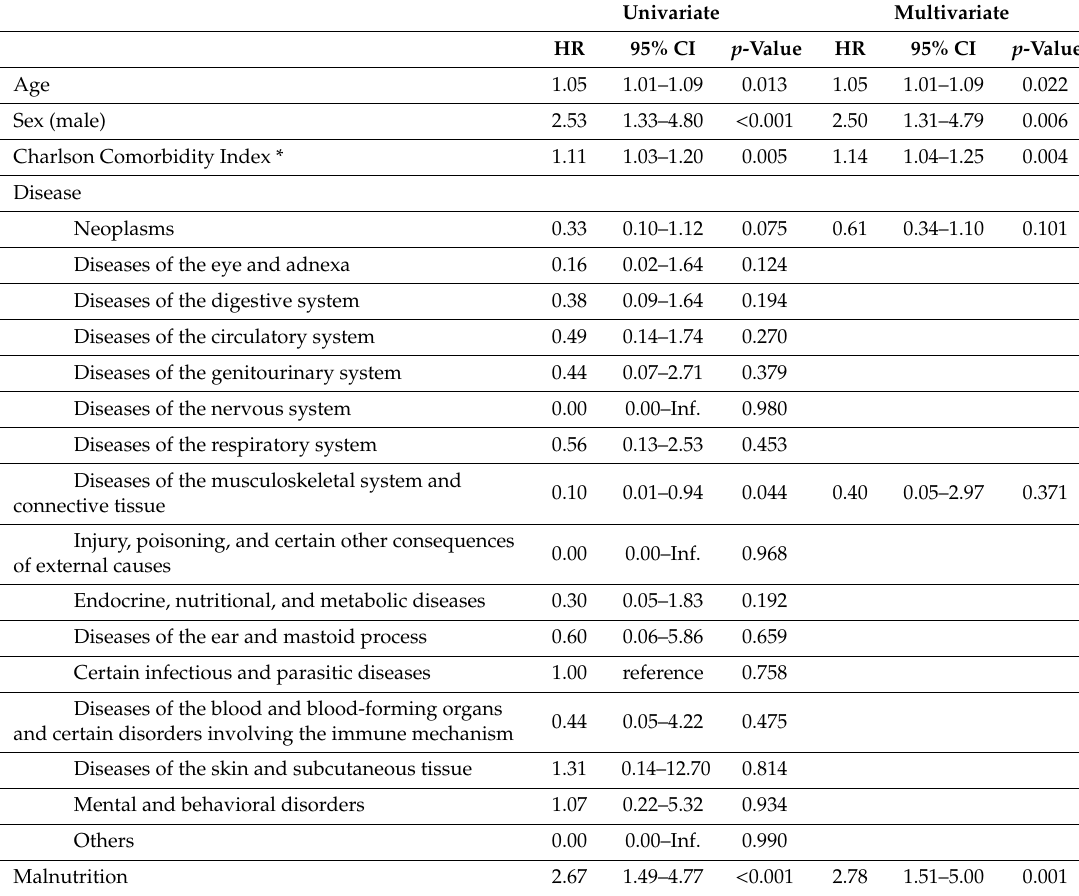
Table 3. Univariate and multivariate analysis for in-hospital